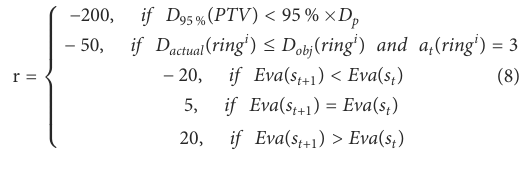
Table 2. For each training case, fi ve DDQN networks independently performed three processes: objectives adjustment, transition storage and sample, and network training. After all objectives were adjusted, an optimization process was performed. In each step, the ϵ greedy algorithm was used for MOAPN to select actions. Speci fi cally, each DDQN network randomly selected its own action among all possible actions with a probability of ϵ . Otherwise, the optimal actions that achieved the highest output value were selected with a probability of 1 - ϵ . The probability ϵ was started at 0.95 and decayed at a rate of 0.95/ episode along the training process, with a minimum of 0.1. Considering that there were fi ve objectives to adjust, fi ve independent experience replay pools each with maximum capacity of 4096 were generated to